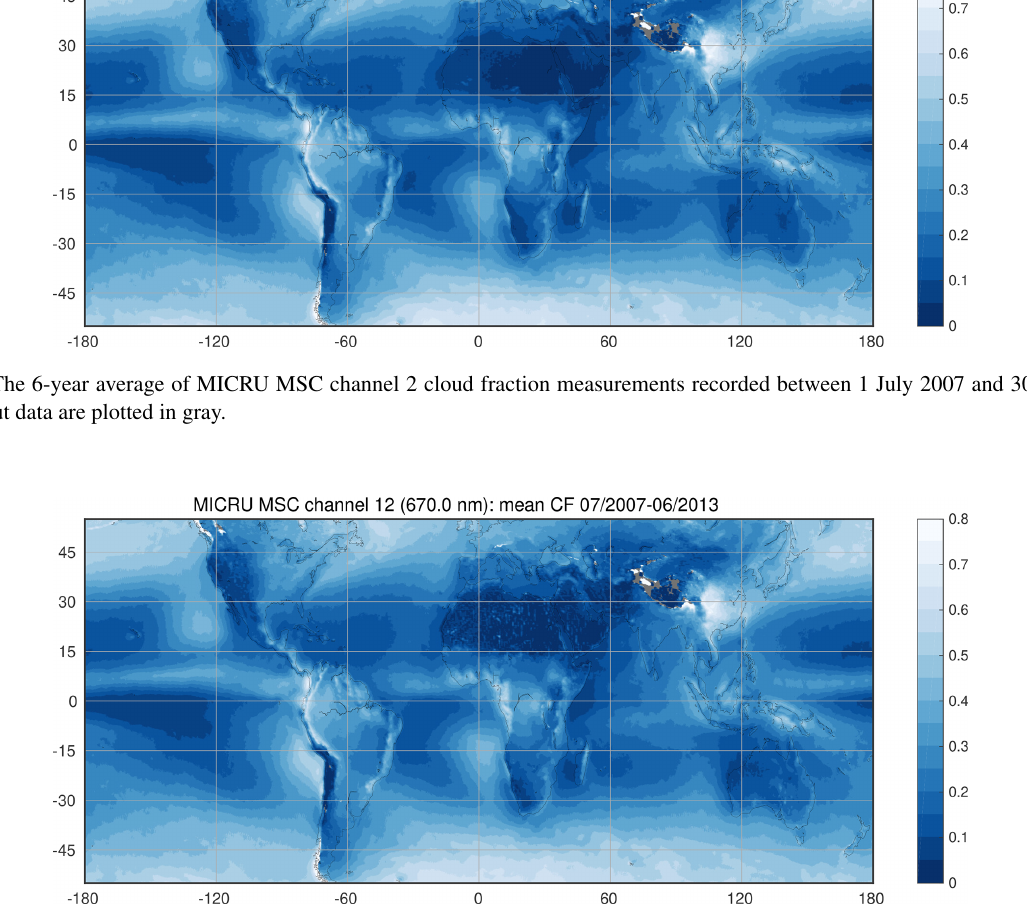
Figure F2. The 6-year average of MICRU MSC channel 12 cloud fraction measurements recorded between 1 July 2007 and 30 June 2013. Areas without data are plotted in